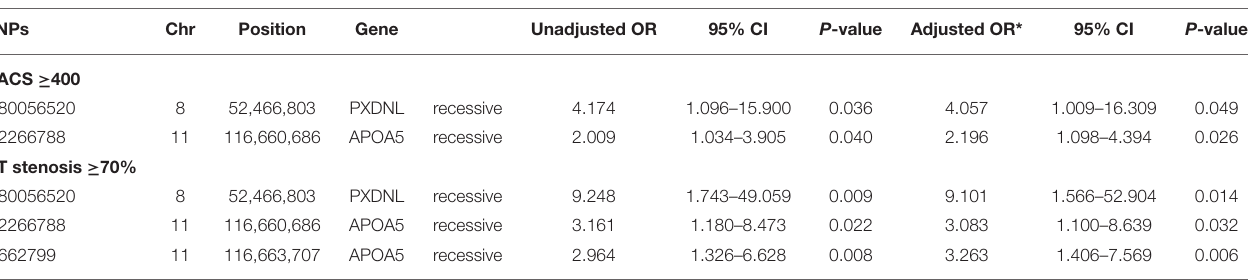
TABLE 3 | Association of lipid variability SNPs with coronary